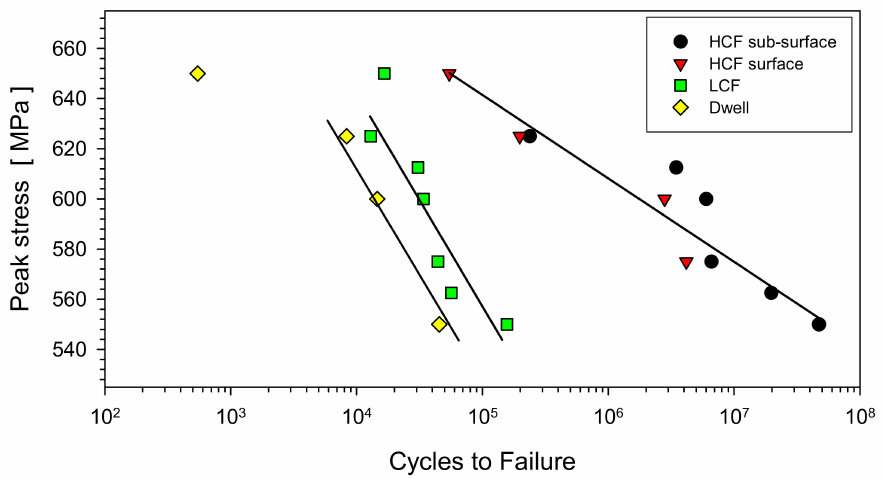
Figure 6. High fatigue cycle (HCF), LCF and dwell fatigue data for Ti-407.